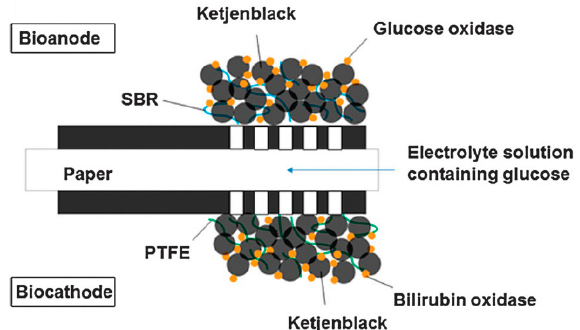
Figure 31. Sceen-printed, paper-based carbon electrodes as bioanodes and biocathodes for a glucose oxidase/bilirubin oxidase BFC. SBR: styrene butadiene rubber. PTFE: polytetrafluoroethylene. Ketjenblack: superconducting carbon black. Reproduced from [145] with permission. Copyright The Royal Society of Chemistry, 2013.